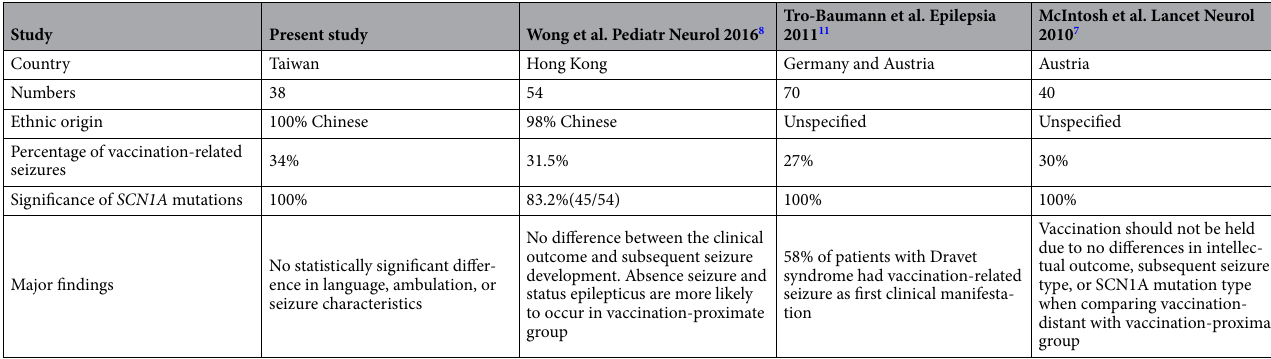
Table 3. Literature review regarding vaccination-related seizures in patients with